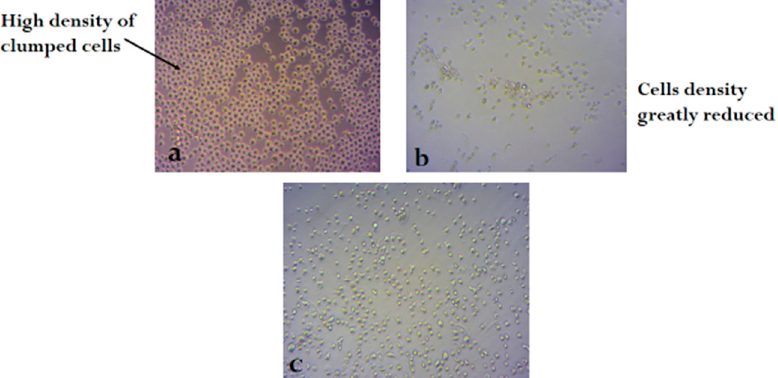
Figure 3. Photomicrograph of colon cancer cell line ( a ) untreated, ( b ) treated with cisplatin, and ( c ) treated with compound 3 (H&E × 100).